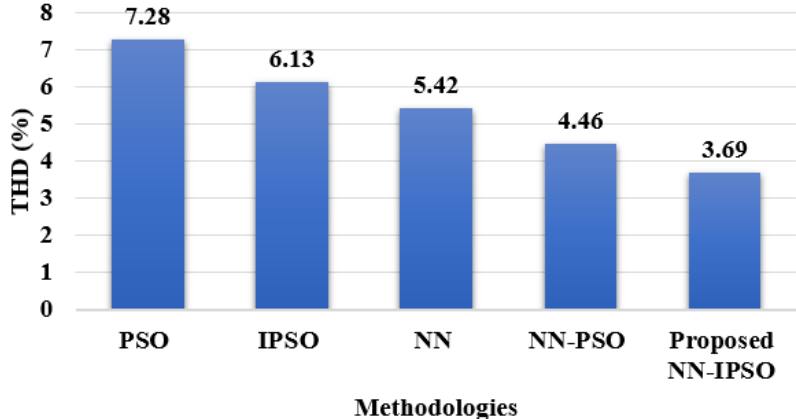
Figure 6. Comparison of Total Harmonic Distortion. Table 3. Comparison table of existing